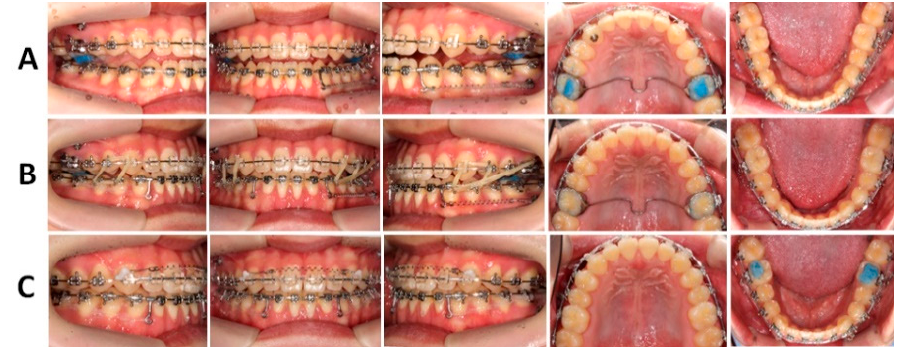
Figure 7. Treatment progress intraoral photographs (( A ) 8 months; ( B ) 11 months; ( C ) 13 months). At fifteen months into treatment, fixed appliances were removed. Maxillary